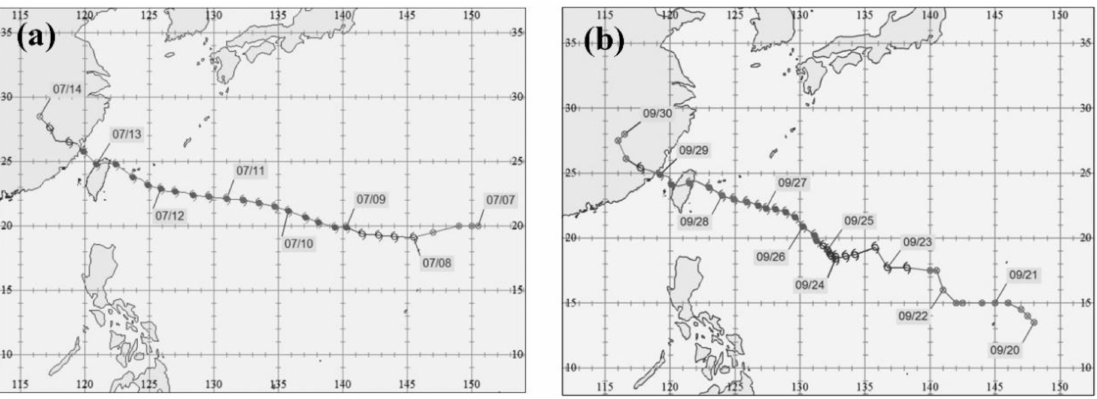
Figure 4. Typhoon tracks of ( a ) Soulik in 2013 and ( b ) Dujuan in